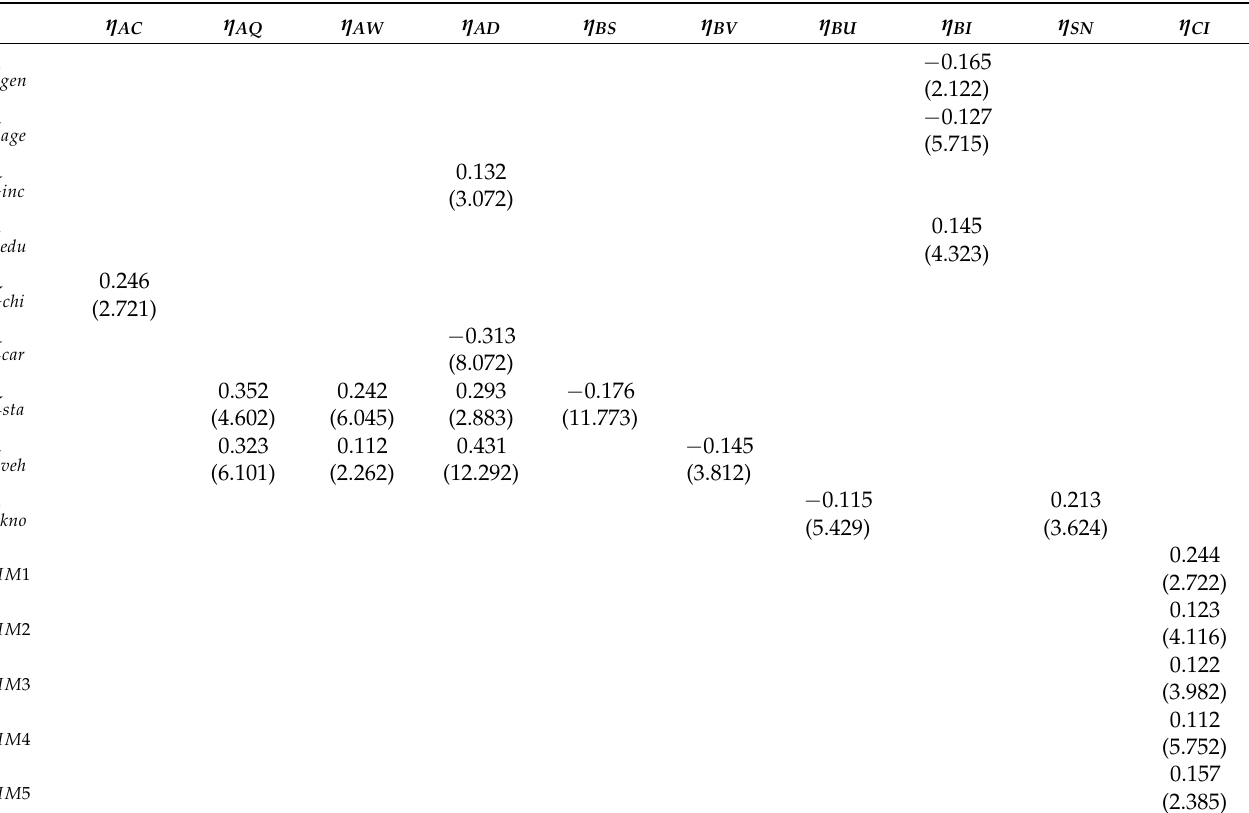
Table 5. The relationship between exogenous variables and latent